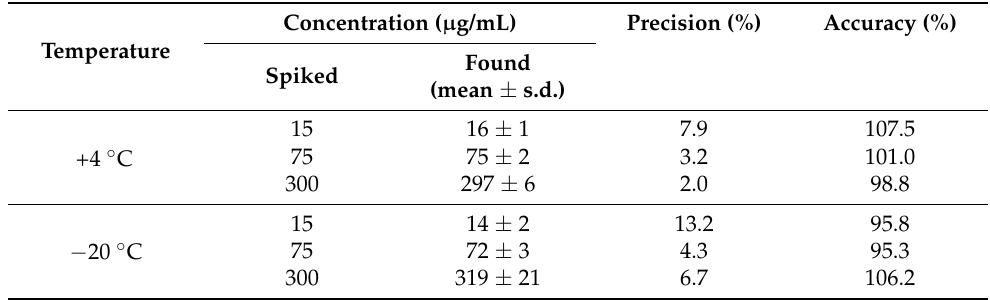
Table 8. Pre-analytical stability of rituximab at − 20 ◦ C over three months and autosampler stability (+4 ◦ C, 72 h), calculated with the pQVQ peptide. Data obtained via LC-MS/MS assay.